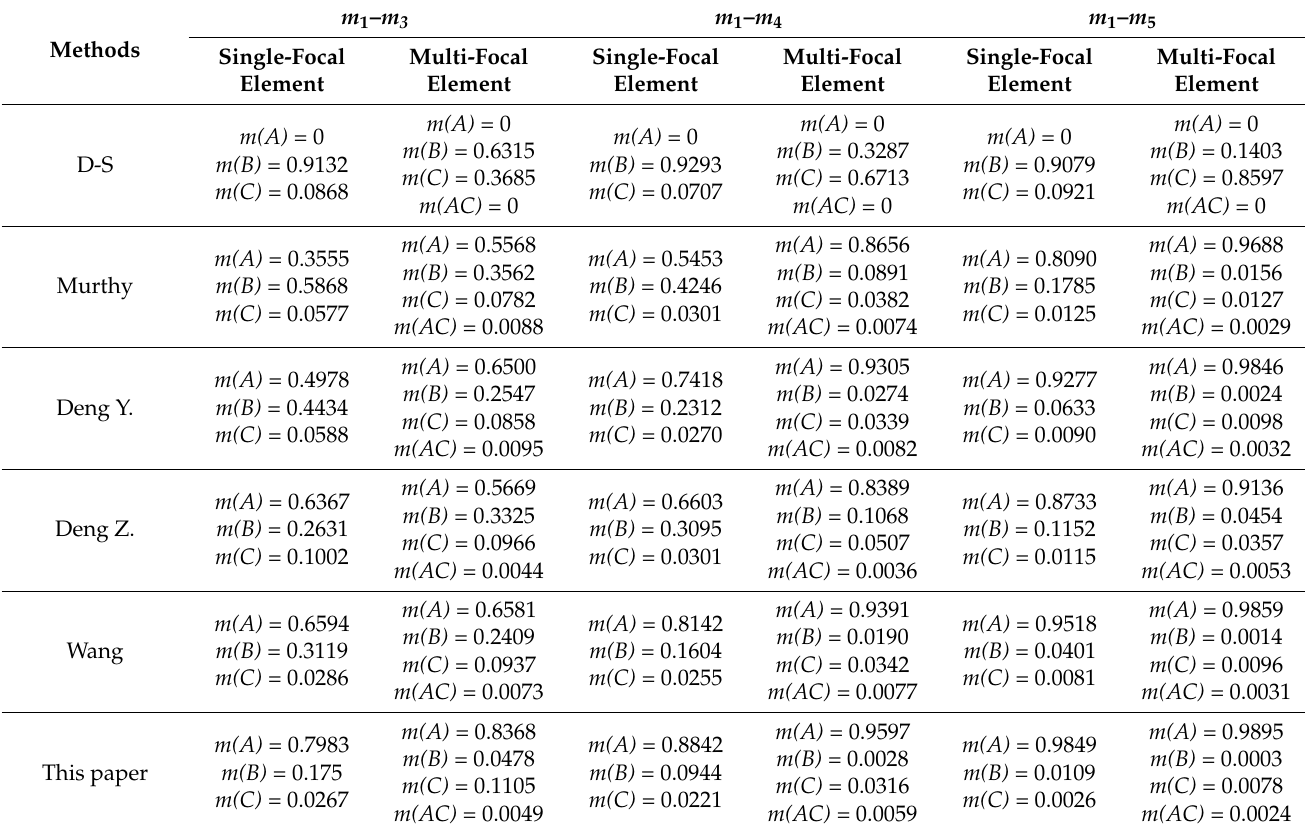
Table 8. Multi-quantity evidence body fusion results.